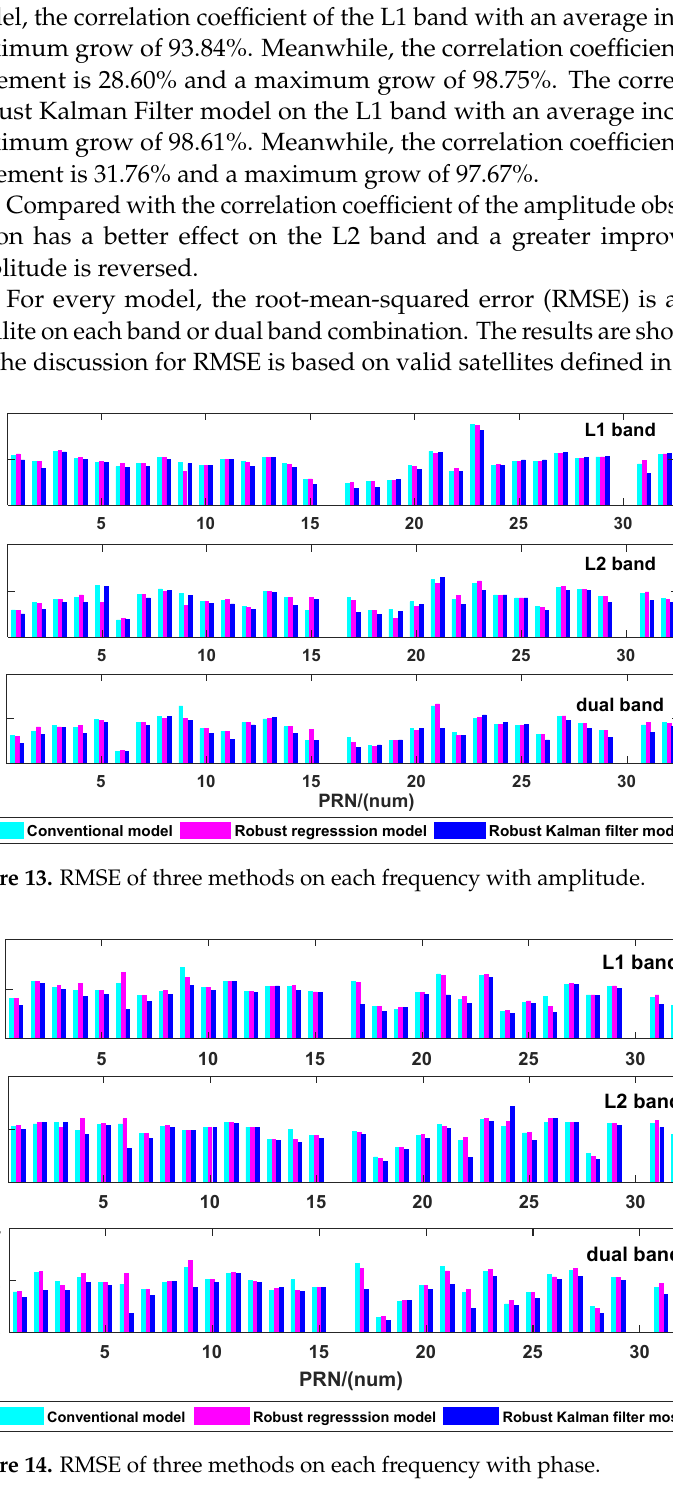
Figure 14. RMSE of three methods on each frequency with phase.